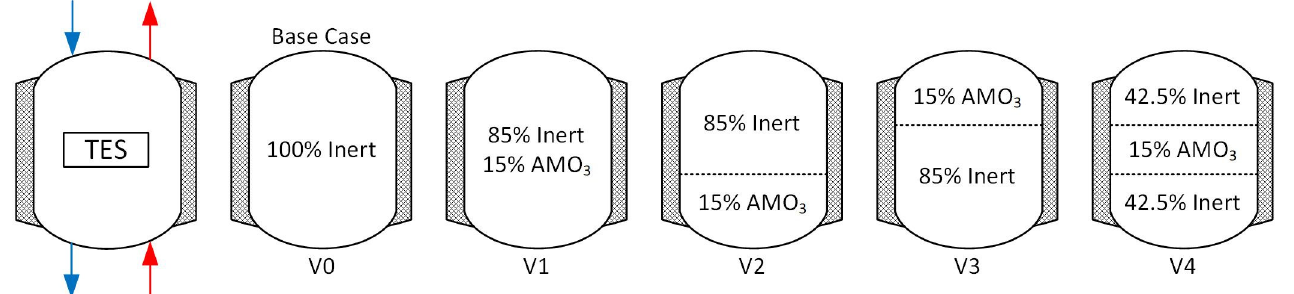
Figure 5. Cascading variations of inert and reactive material. The TES is operated in a cycling approach. During charging (blue) the flow direction is from top to bottom and vice versa during the discharge (red) of the TES.